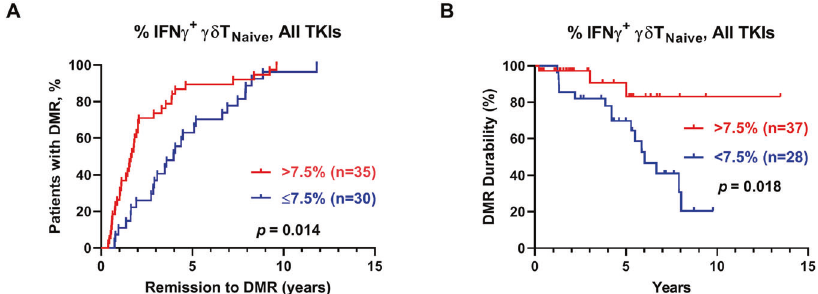
Fig. 6 γδ T-cell activation with IFN- γ expression shortening time to DMR and sustaining DMR durability. A Patients were dichotomized to low and high naïve γδ T cells IFN- γ secretion groups. The cumulative rate to reach DMR was correlated with the fraction of IFN- γ + naïve γδ T cells (7.5% as the optimal cutoff, according to the receiver-operating characteristic (ROC) curve and the Youden index analyses (AUROC 0.6720; 95% CI: 0.5346 – 0.8095). B The cumulative rate of DMR durability was associated with the fraction of IFN- γ + naïve γδ T cells > 7.5%. P -values are calculated using the cumulative incidence approach and the Mentle-Cox